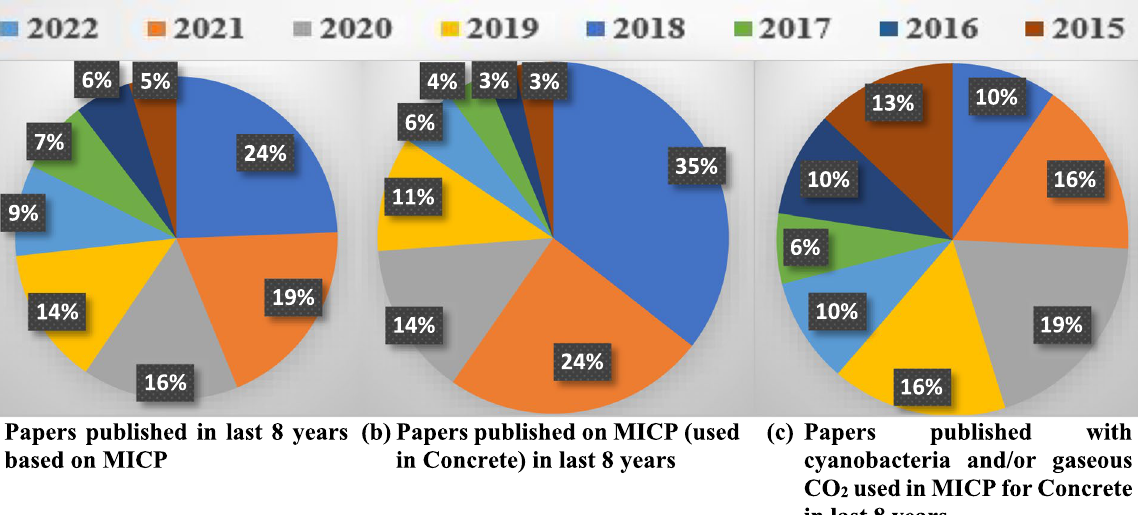
Fig. 2 Pie chart on approximate research works done on MICP and its utilization on concrete healing for the last 8 years, where a represents the overall papers published on MICP, b represents the percentage of paper published on MICP which is used in Concrete, and c represents paper published specially with cyanobacteria and/or gaseous CO 2 used in MICP for